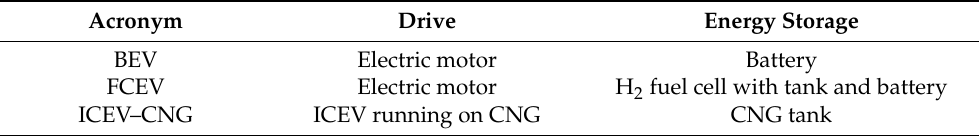
Table 2. Major drive and energy storage technologies used in the simulation